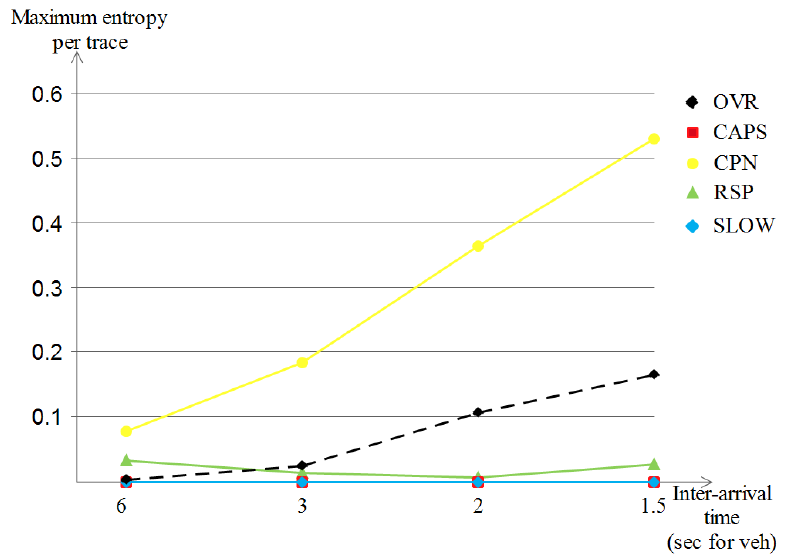
Figure 16. Maximum entropy per trace of privacy schemes in the highway